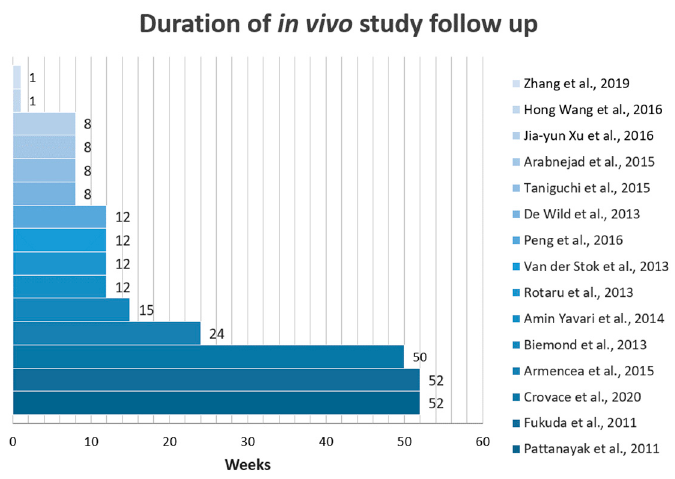
Figure 3. Duration of follow-up period of in vivo included studies.